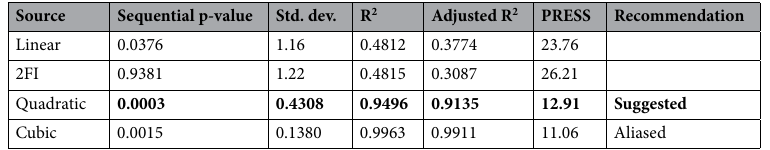
Table 5. Model summary statistics of wear rate for QAM f steel. Significant values are in bold.